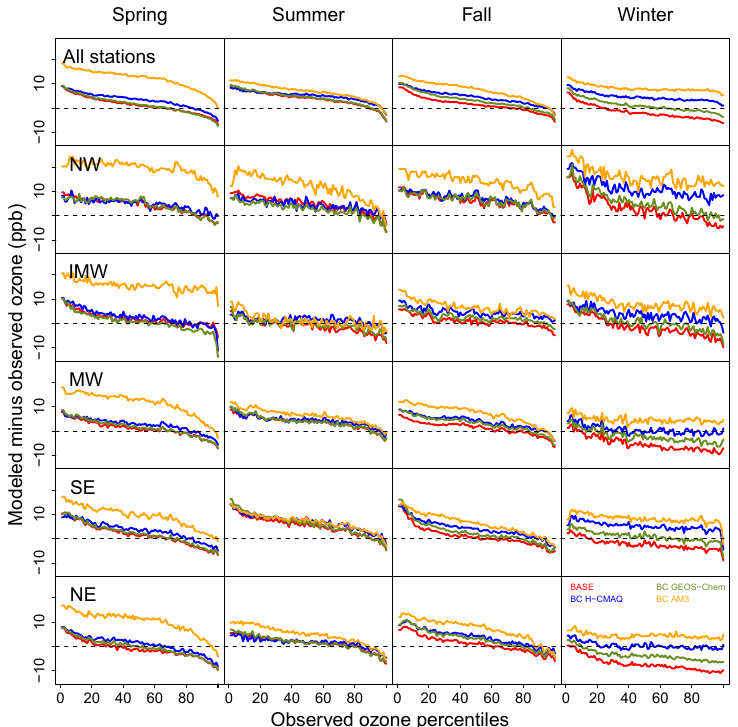
Figure 13. Paired-in-time differences between observed and modeled MDA8 ozone at AQS stations for each season and analysis region. Model results are for BASE (red), BC H-CMAQ (blue), BC GEOS-Chem (green), and BC AM3 (orange). For each season and region, the observed MDA8 ozone concentrations were rank ordered at each station. Next, differences between CMAQ simulations and observations were computed for each observed percentile by selecting the model value corresponding to the date of the observed percentile. Finally, the median value of these paired-in-time differences across all AQS stations in a given season and region was then computed for each observed percentile and is depicted in this